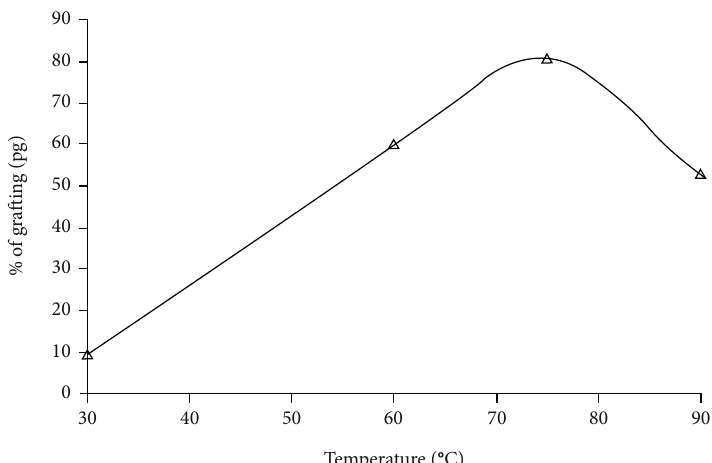
Figure 2: E ff ect of reaction temperature on the % of grafting in pg. Reaction time: 60 min, AN: 8 ml, H of grafting.